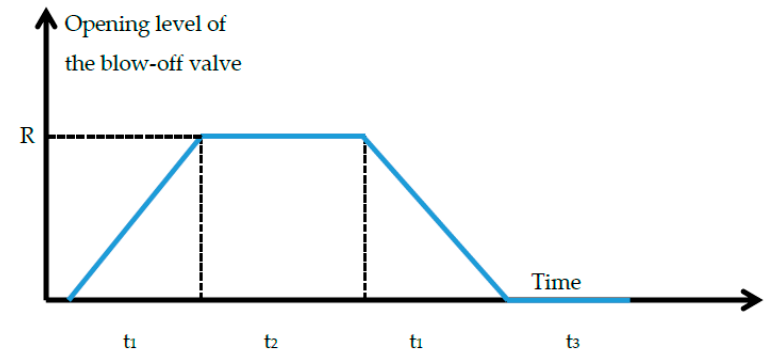
Figure 13. Operation of the blow-off valve.